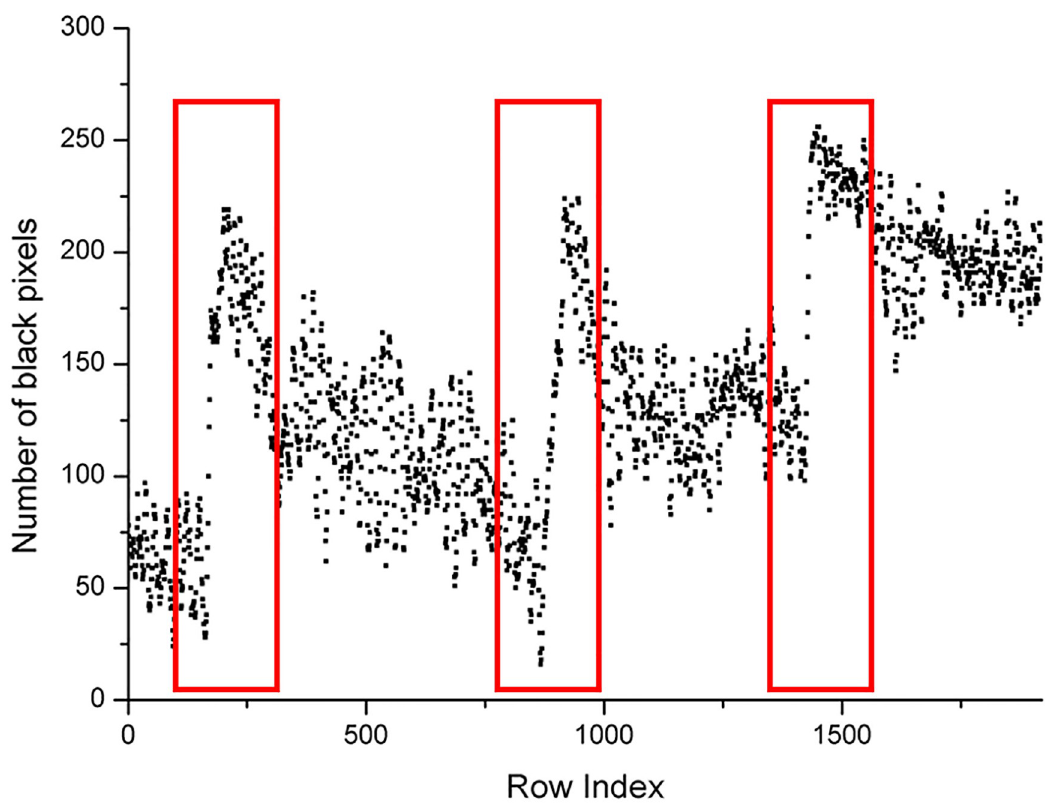
Fig 9. Scatter plot of the number of black pixels of Fig